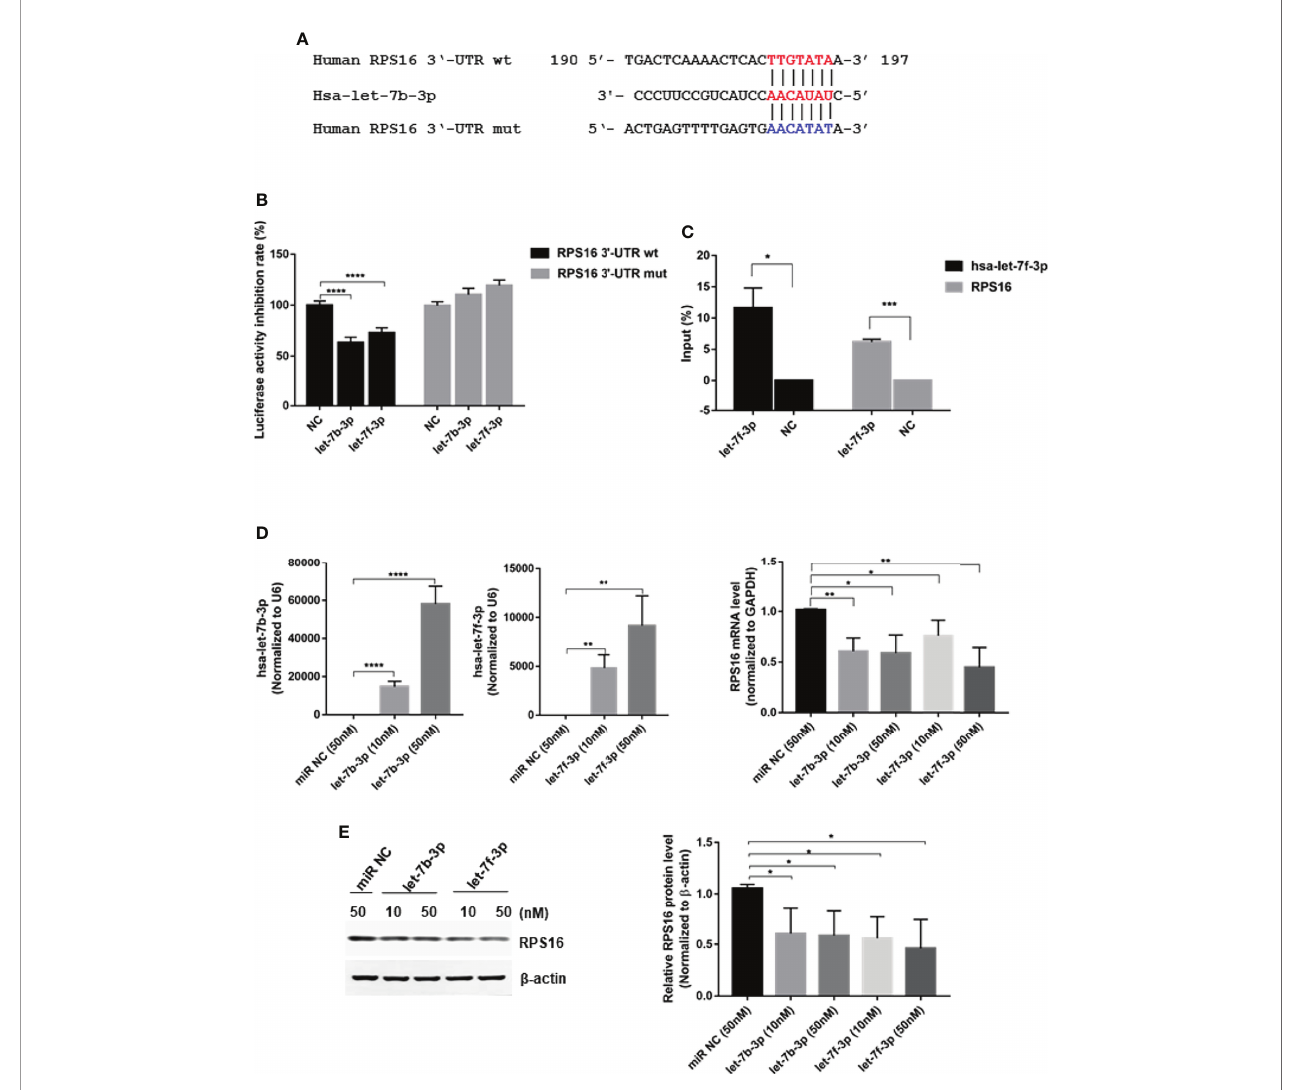
FIGURE 3 | RPS16 is a direct target of let-7. (A) Schematic representation of predicted target sites of hsa-let-7b-3p in the 3 ’ -UTR of RPS16 and mutant RPS16 3 ’ - UTR reporter constructs. (B) 293T cells were co-transfected with RPS16-3 ’ -UTR luciferase reporter plasmid, RPS16-3 ’ -UTR mut luciferase reporter plasmid (100ng/ well), together with negative mimic (miR NC) or let-7b-3p/let-7f-3p mimic (50 nM). After 48 h, fi re fl y luciferase activity was measured and normalized to Renilla luciferase activity. Data are the mean ± SD from four independent experiments. (****P < 0.0001 vs. negative mimic by t -test. (C) RNA pulldown assay indicated that biotin − hsa-let-7b-3p precipitated with RPS16 mRNA, Lac Z(NC)served as a negative control, the precipitated mRNA was reverse transcripted into cDNA and detected by RT-PCR, the relative expression level was compared to the gene expression in the input RNA. Data were shown as mean ± SD, * p < 0.05, *** p <